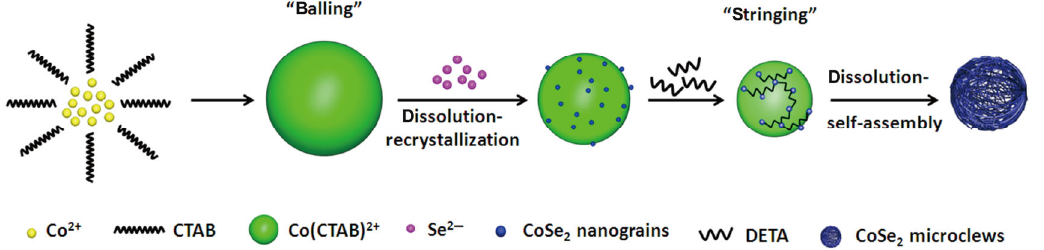
Fig. 5 SEM images of the CoSe 2 samples synthesized at 180 ℃ in a mixed solvent (40 mL, V DETA : V H2O = 2:1) with 1.5 mmol CTAB at different time points of the hydrothermal reaction: (a) 15 min, (b) 1 h, (c) 4 h, (d) 6 h, (e) 12 h, and (f) 16 h.